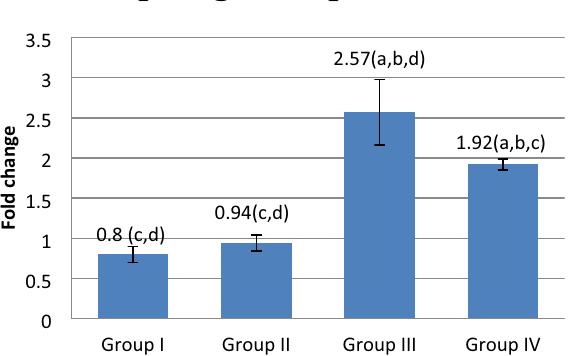
Figure 2. Effect of FUC treatment on Mapk1 mRNA gene expression. values are represented as mean ± SD. Data are represented as mean ± SD. Statistical analysis was carried out using one-way ANOVA with Tukey’s post hoc test, SPSS computer program. a–d Significant difference between groups at * p < 0.05. a Significance from group I; b significance from group II; c significance from group III; d significance from group IV. Degree of freedom is (3) between groups and (24) within groups (total =